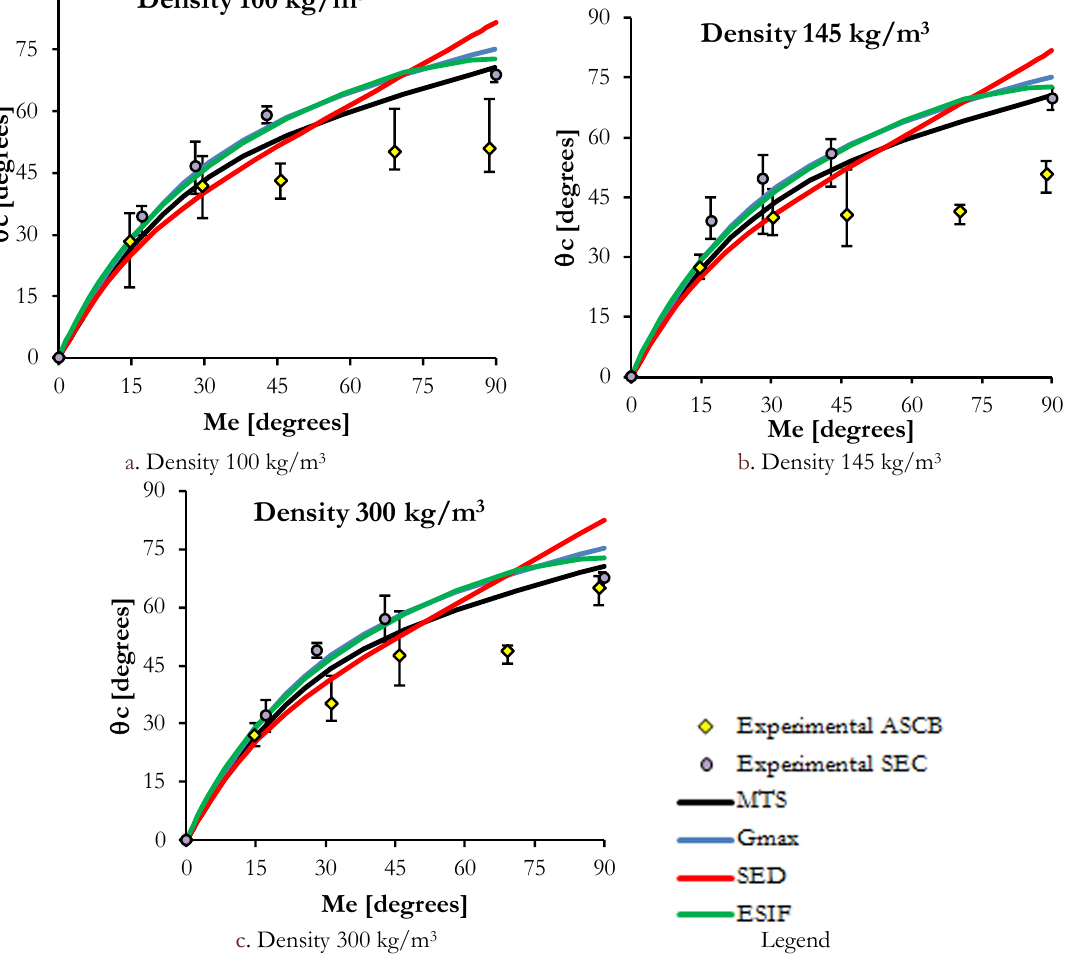
Figure 7 : Comparison between experimental and theoretical crack initiation